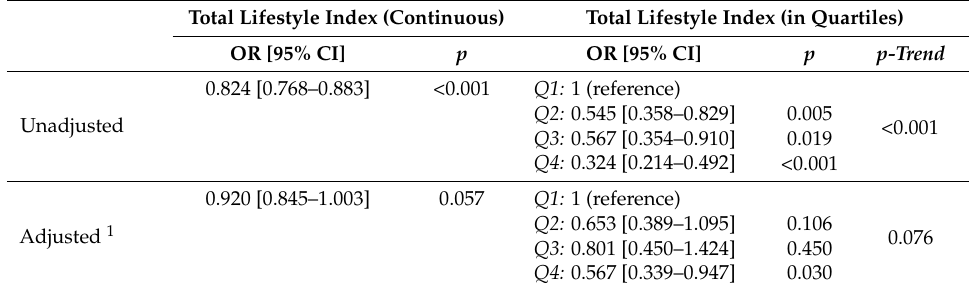
Table 6. Results from logistic regression analysis that evaluated the association between Total Lifestyle Index and low cognitive performance (dependent variable) in non-demented, non-MCI participants.